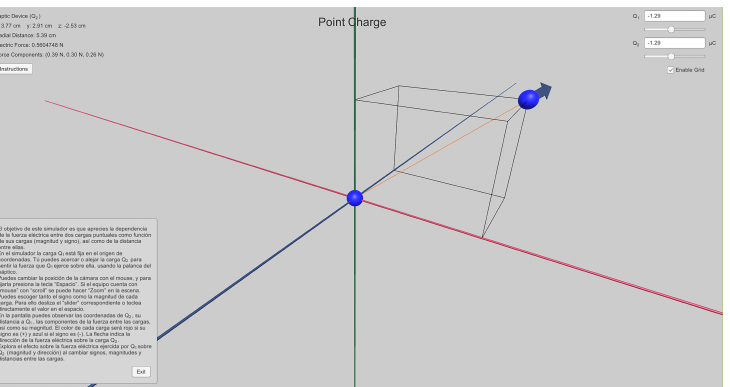
Figure 8. Interface elements of the point charge visuo-haptic environment developed with VIS-HAPT and HaDIU architecture.